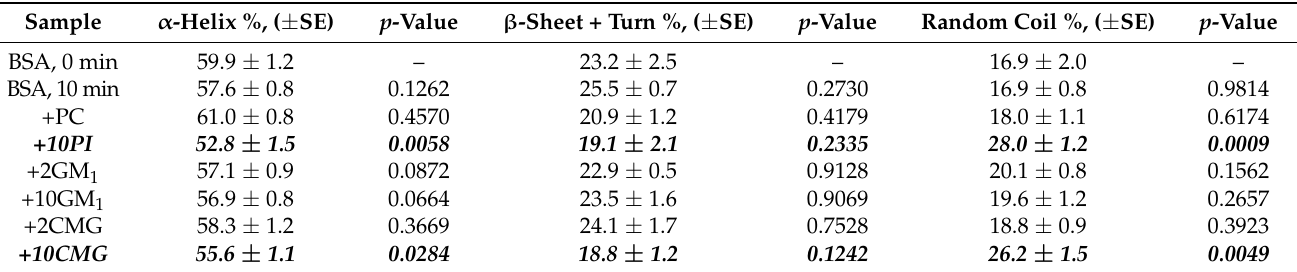
Table 4. Secondary structure elements calculated from FTIR spectra of BSA alone and after incubation with the liposomes. FTIR spectra were recorded in PBS at 37 ◦ C, lipid concentration of 12 mM, and albumin concentration of 6 mg/mL. Fitting procedure was conducted using Levenberg-Marquardt method with peak type parameter as Gauss or if unavoidable as Gauss and Lorentz combination. Null hypothesis is that BSA structure during incubation is the same as at 0